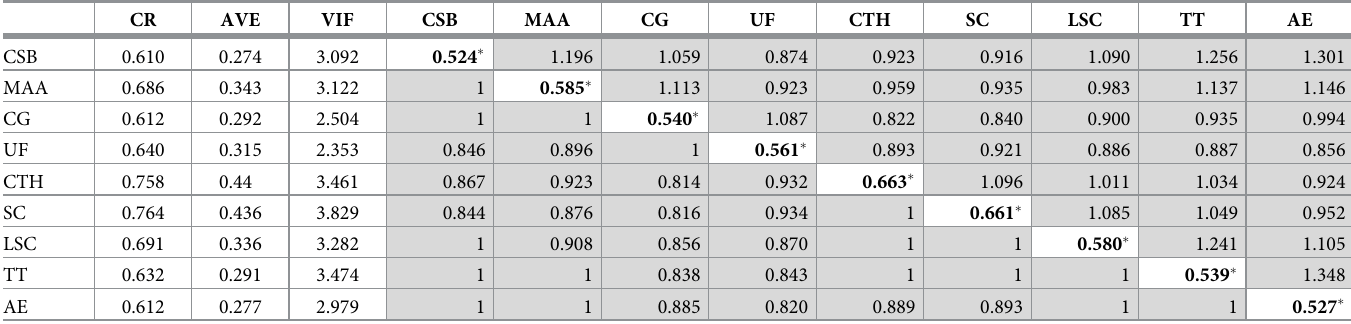
Table 5. Results of the convergent and discriminant validity of the DFS-BR. CR